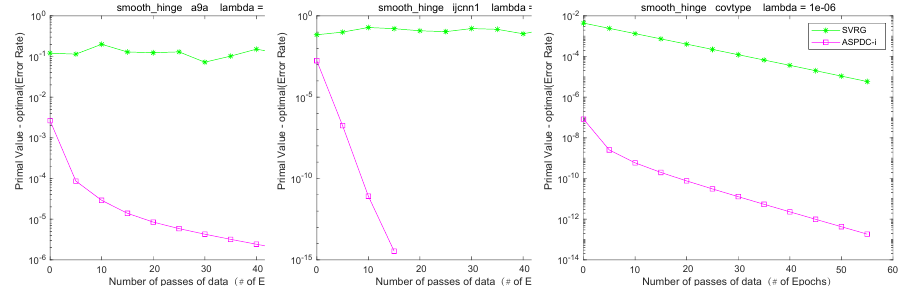
Figure 3. Optimal primal value ( y -axis) vs. the number of epochs ( x -axis): Comparing ASPDC-i with SVRG for smooth hinge SVM on real-world datasets with the regularization coefficient 10 − 6 . The x -axis is the number of passes through the entire dataset, and the y -axis is the logarithmic dual-gap.